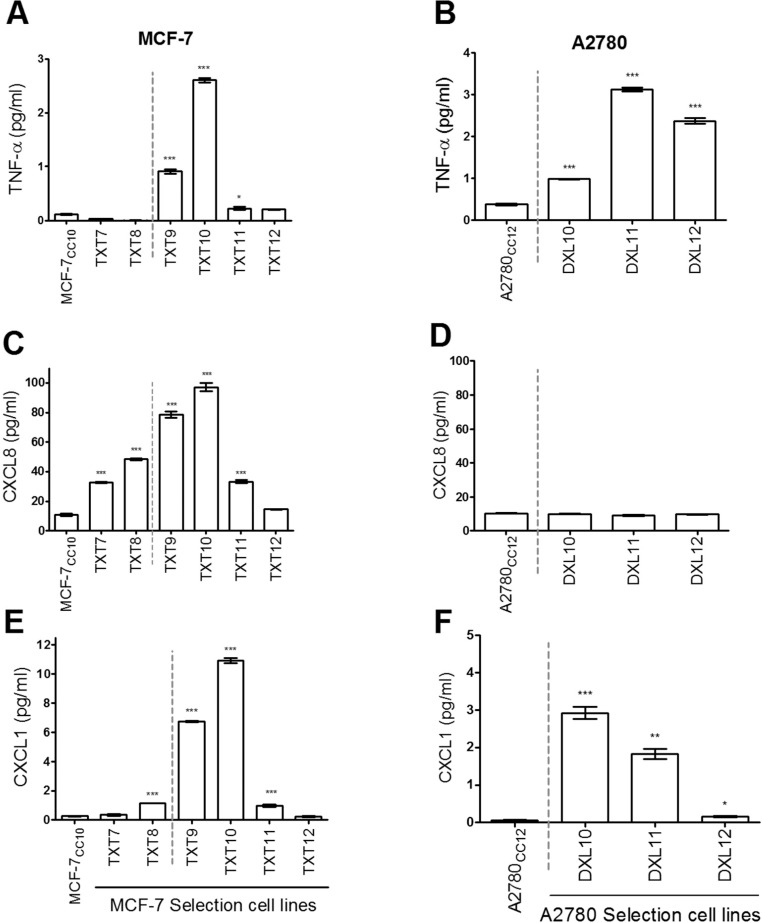
Basal cytokine production changes during selection for resistance to docetaxel.Levels of TNF-α (A and B), CXCL8 (C and D), and CXCL1 (E and F) in media as measured by ELISA, from MCF-7 (A, C, and E) and A2780 cells (B, D, and F) after 72 hours of cell culture. Cell lines to the right of the vertical broken grey line exhibit acquired resistance to docetaxel, as confirmed in clonogenic assays. Each value represents the mean of three replicates (+/-SEM). Two-tailed T-tests were used to assess the significance of differences in cytokine levels between docetaxel-selected cell lines and their respective co-cultured control cell lines (MCF-7CC10 or A2780CC12); ***p<0.0001, **p<0.001, *p<0.01.